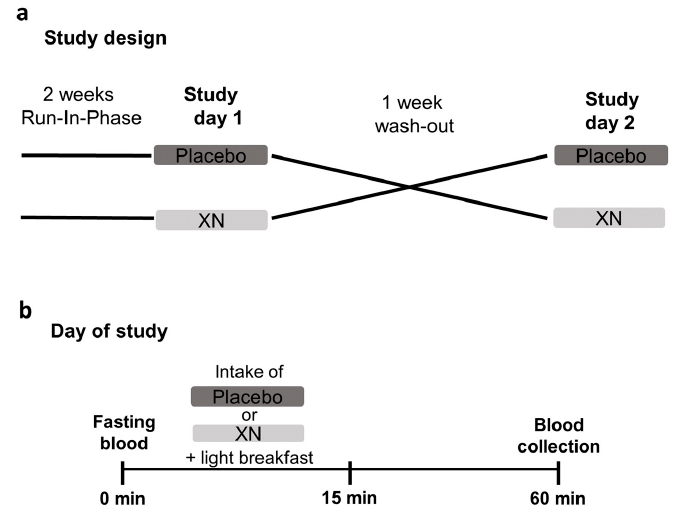
Figure 2. Graphical visualization of the study design. ( a ) Study design and ( b ) the procedure per- formed on each day of the study. XN, xanthohumol derived though a xanthohumol-rich hop extract.